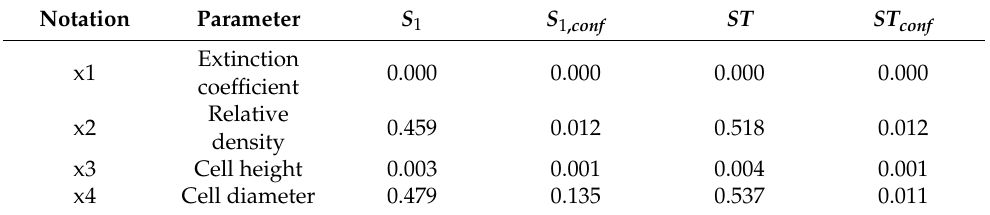
total effective thermal conductivity.